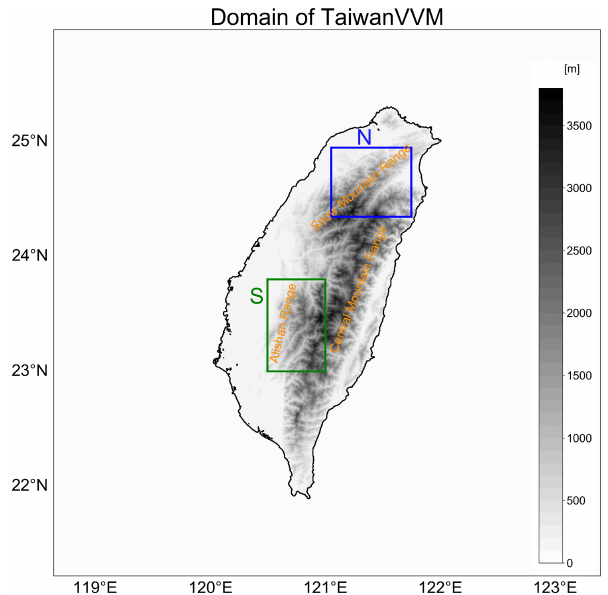
Figure 1. The domain of TaiwanVVM with the 500m resolution topography of the island of Taiwan (grey shading). The boxes are the mountain areas for subsequent statistical analyses: the blue box is the northern mountain area (area N), and the green box is the southern mountain area (area